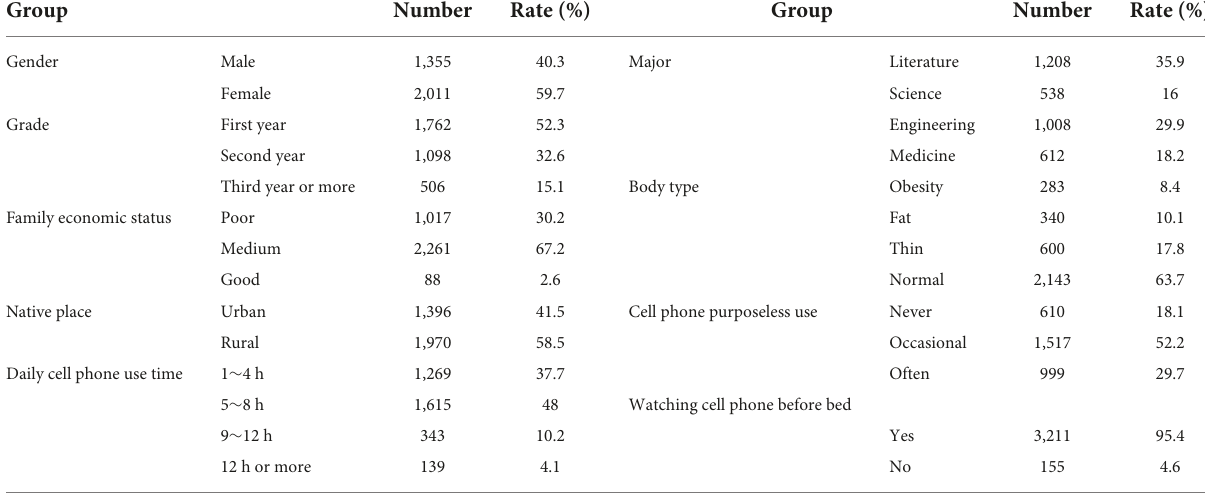
TABLE 1 Basic characteristics of participants.